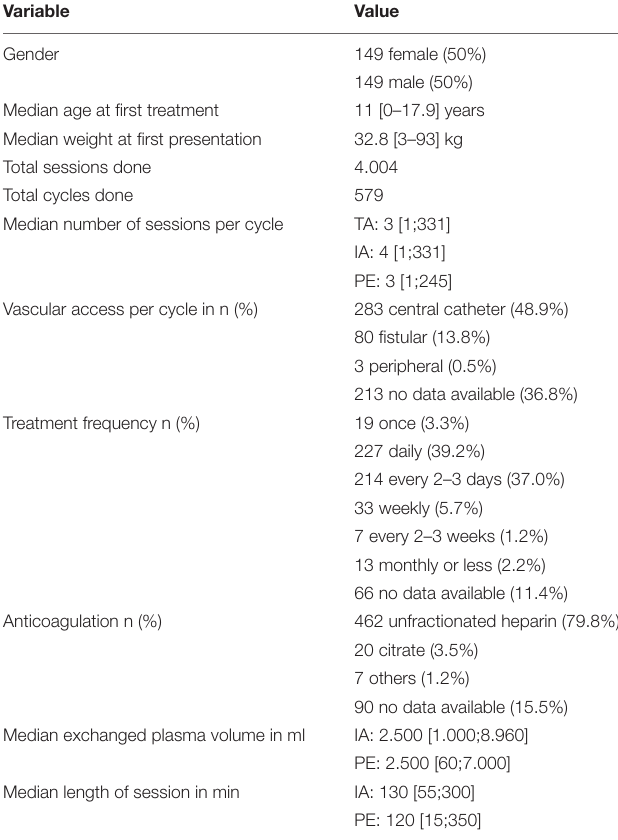
TABLE 1 | Patients